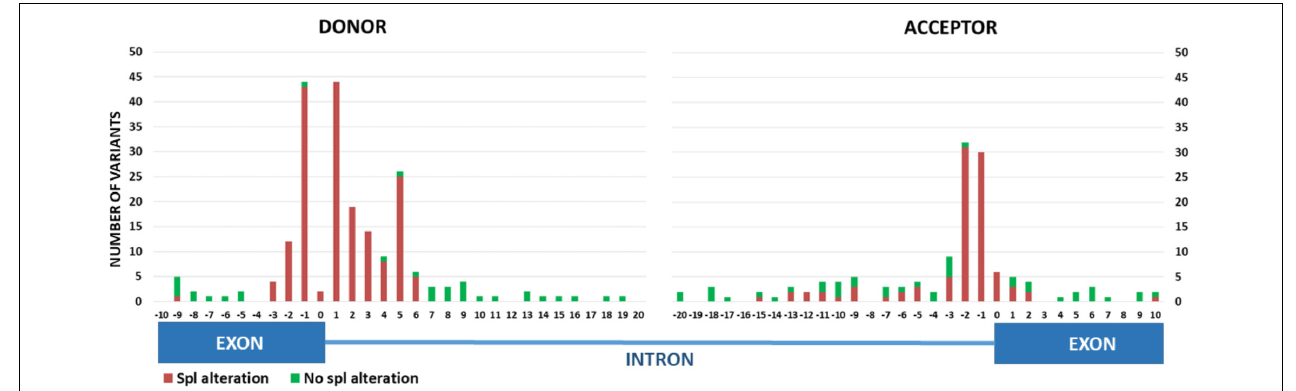
FIGURE 3 | In vitro RNA results collected in the validation set. Experimental data are displayed according to variation location. Variants located at 0 position are those that affect the invariable dinucleotide positions (GT or AG) plus other contiguous nucleotides. Positive splicing alterations include: exon skipping, use of a new or cryptic splice site or an altered-alternative transcript profile. Negative splicing alteration: in vitro RNA result was exactly the same as that obtained in control samples. Spl,